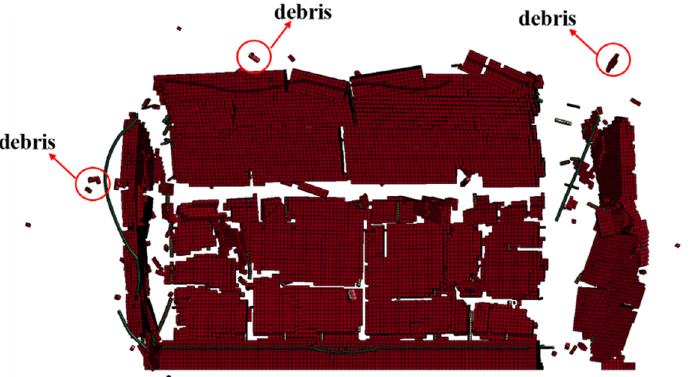
Figure 21. Model failure form.